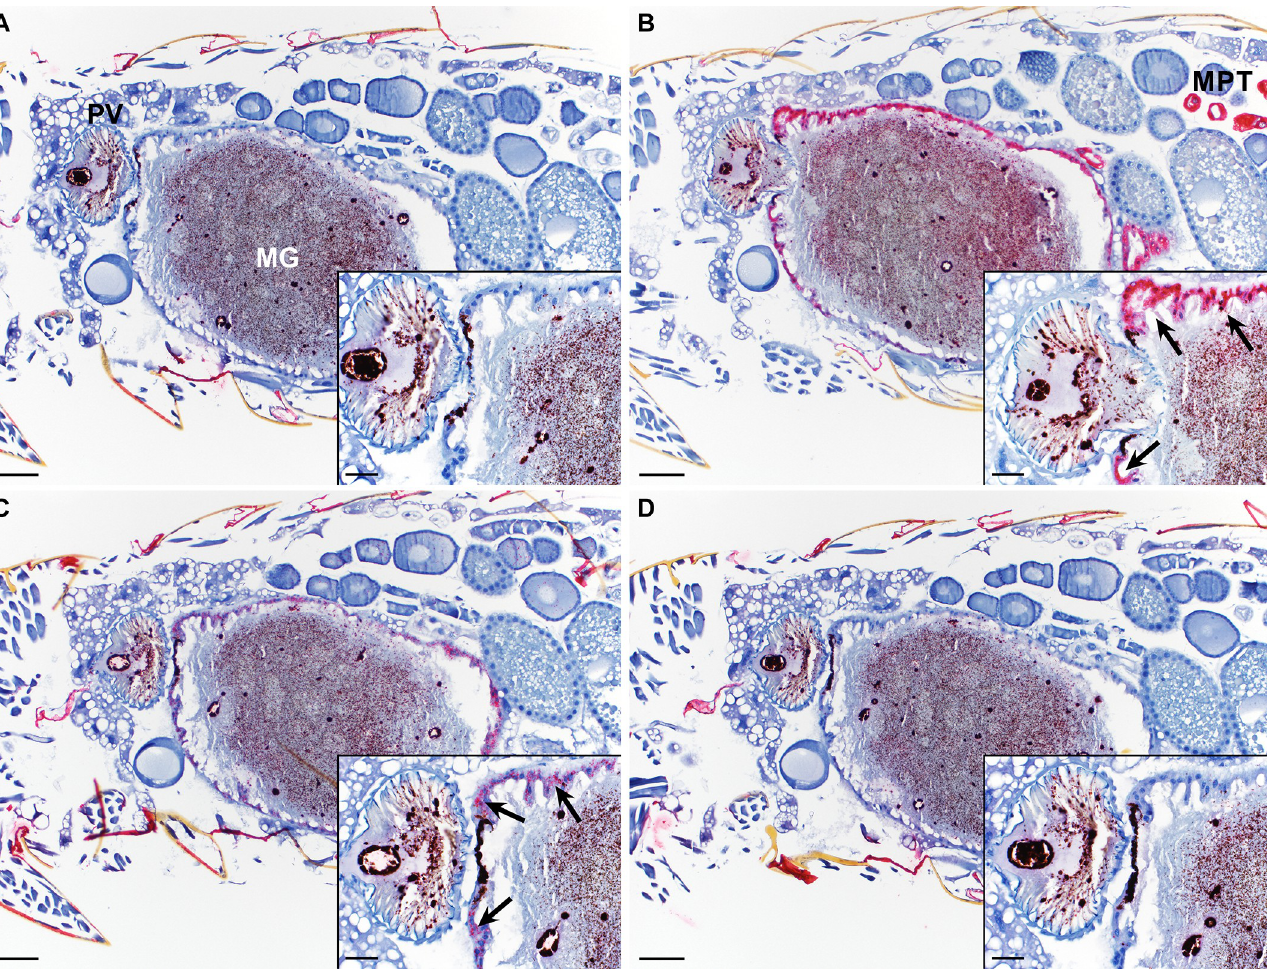
Fig 6. Detection of peritrophin transcripts in tissues of infected fleas using in situ hybridization. Fixed sections of whole fleas infected with KIM6+ Y . pestis were hybridized to probes with specificity for 1 of 4 different mRNA transcripts: A) Ajuba (mouse-specific transcript; negative control), B) a trypsin-like serine protease (XcSigP-74269; positive control), C) peritrophin A (XcSigP-41404), or D) peritrophin B (XcSigP-32200). Tissues stain red (Fast Red dye) where transcript was detected. The proventriculus (PV) and midgut (MG) epithelium are magnified in the inset images in the bottom right corner of each panel and arrows highlight areas of strong (trypsin like-serine protease; panel B) or moderate multifocal (Peritrophin A; panel C) staining in the midgut epithelia. (MPT) Malpighian tubules. Images are representative of groups of 6 fleas per transcript. Non-specific staining of the flea cuticle was detected but occurred equivalently across all treatment groups. Slides were counterstained with hematoxylin (blue). Scale bars for larger images = 50 μ m, inset images = 20 μ